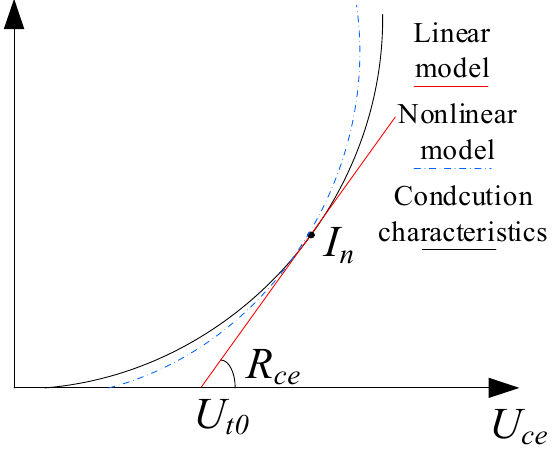
Figure 2. Linear model and nonlinear model.